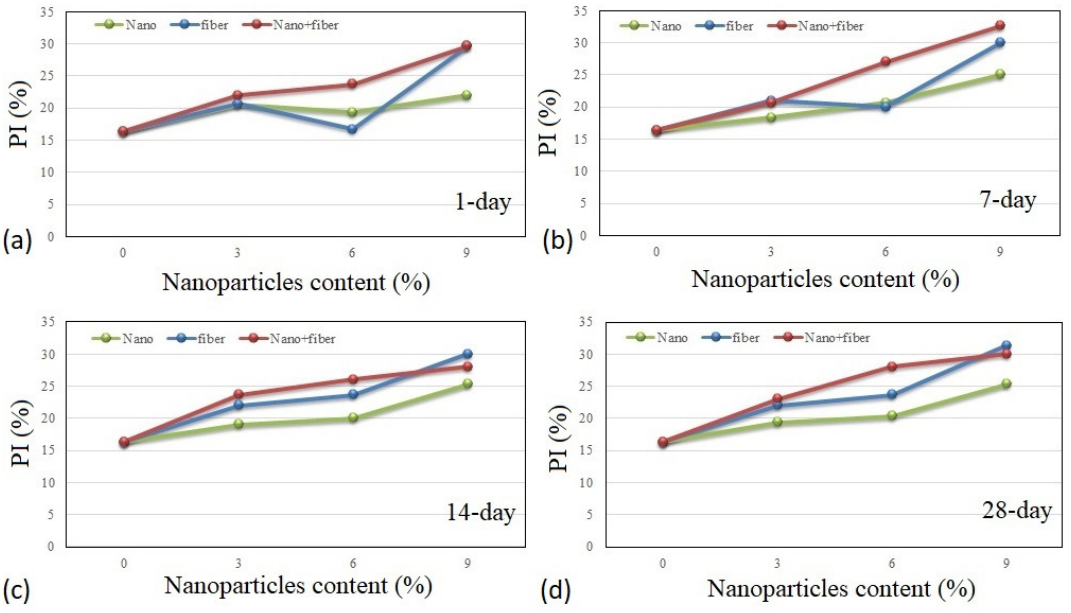
Figure 8. Plasticity index results were measured for different groups of the samples: ( a ) 1-day, ( b ) 7-day, ( c ) 14-day, ( d ) 28-day.